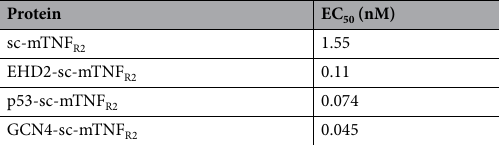
Table 1). Next, we used quartz crystal microbalance measurements to determine the affinity of the fusion proteins to mouse TNFR2-Fc. Using a high density chip (270 Hz) with saturated immobilized TNFR2, strong binding of sc-mTNF was determined for sc-mTNF R2 . Minor differences were observed between EHD2-sc-mTNF R2 , p53-sc-mTNF R2 and GCN4-sc-mTNF R2 , with GCN4-sc-mTNF R2 showing the lowest off-rate. We, therefore, investigated, if differ- ences between EHD2-sc-mTNF